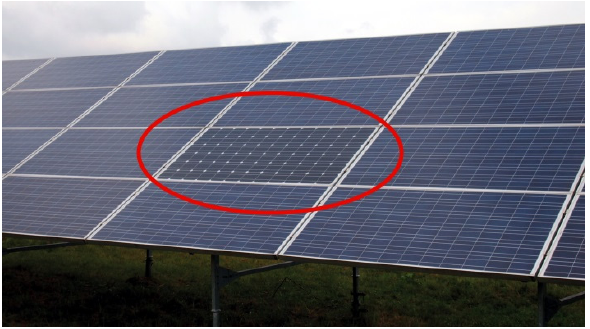
Figure 11. Monocrystalline PV panel used in string with Multi-crystalline PV panels of different parameters